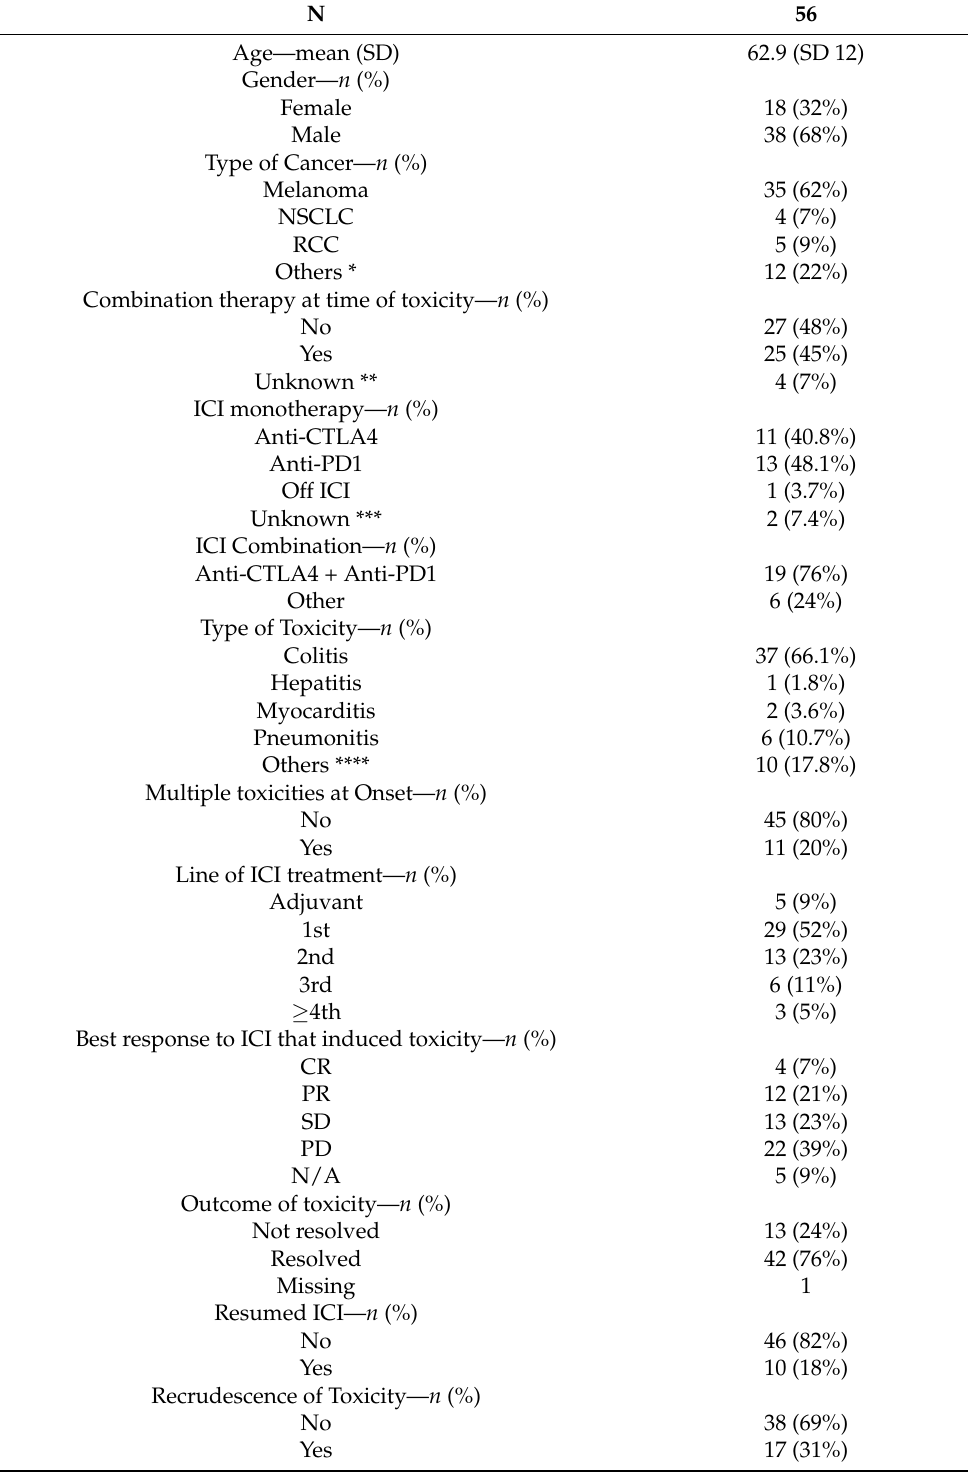
Table 1. Characteristics of patients treated with infliximab. * Other cancer types are HNSCC, Uveal melanoma, esophageal-gastric adenocarcinoma, urothelial carcinoma, pancreas, breast. ** Participating in clinical trials randomizing to receive combination versus ICI monotherapy. *** Participating in clinical trials randomizing to receive either anti-CTLA-4 or anti-PD1. **** Other toxicities are erythema multiform dermatitis, arthritis, type 1 diabetes, Stevens–Johnson syndrome, rash, bullous pemphigoid, enteritis, and cytokine release syndrome. NSCLC = non-small cell lung cancer; RCC = renal cell